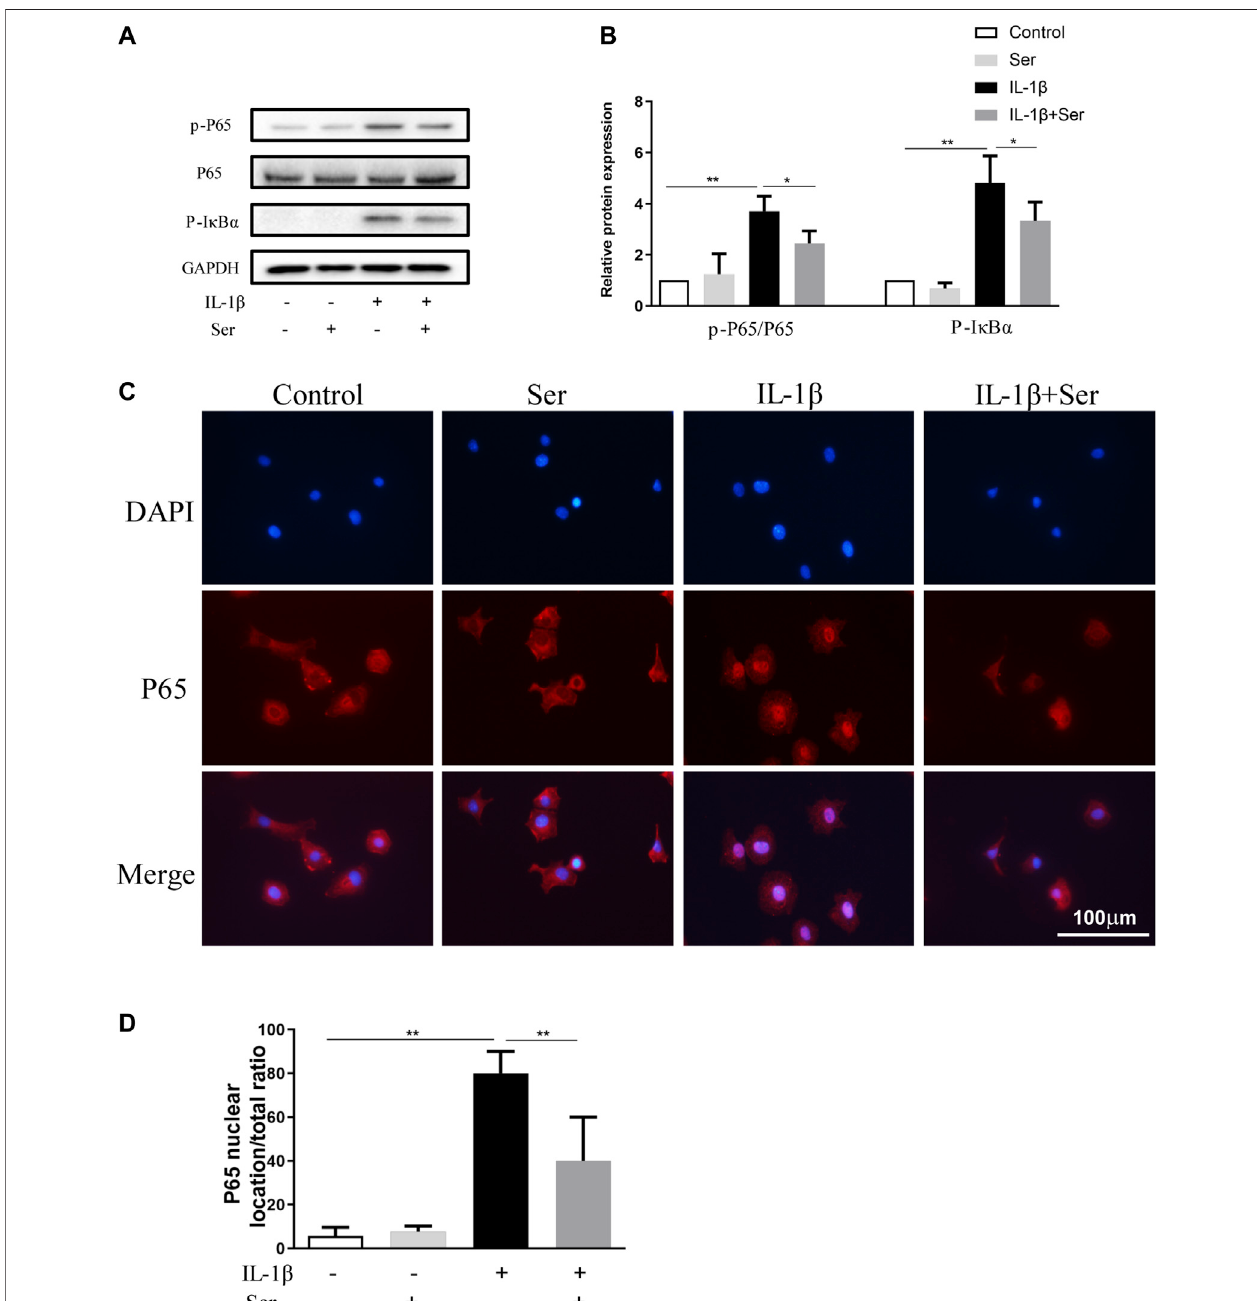
FIGURE 5 | Ser blocks the activation of NF κ B pathway in IL-1 β -treated chondrocyte. Cells were exposed to L-1 β (10 ng/ml) with or without 25 μ M Ser for 30 min. (A) Western blot and (B) quantitative analysis of P-P65 and P-I κ B α . P65 and GAPDH were used as the loading control respectively. (C) P65 nuclear translocation was detected using immuno fl uorescence. (D) Quantitative analysis of P65 nuclear location ratio of each group. p p < 0.05, pp p < 0.01, n (cid:2) 3.